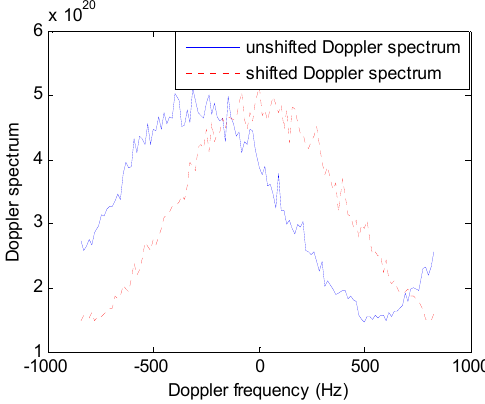
Figure 4. Unshifted and shifted Doppler spectra.